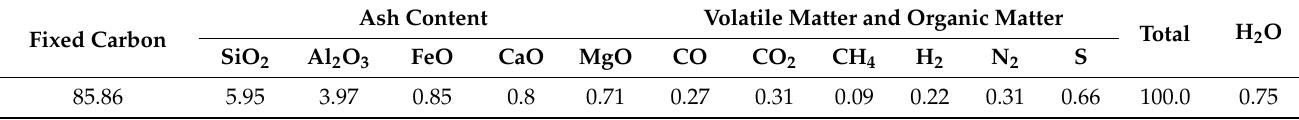
Table A7. Coke composition for calculation (mass%).